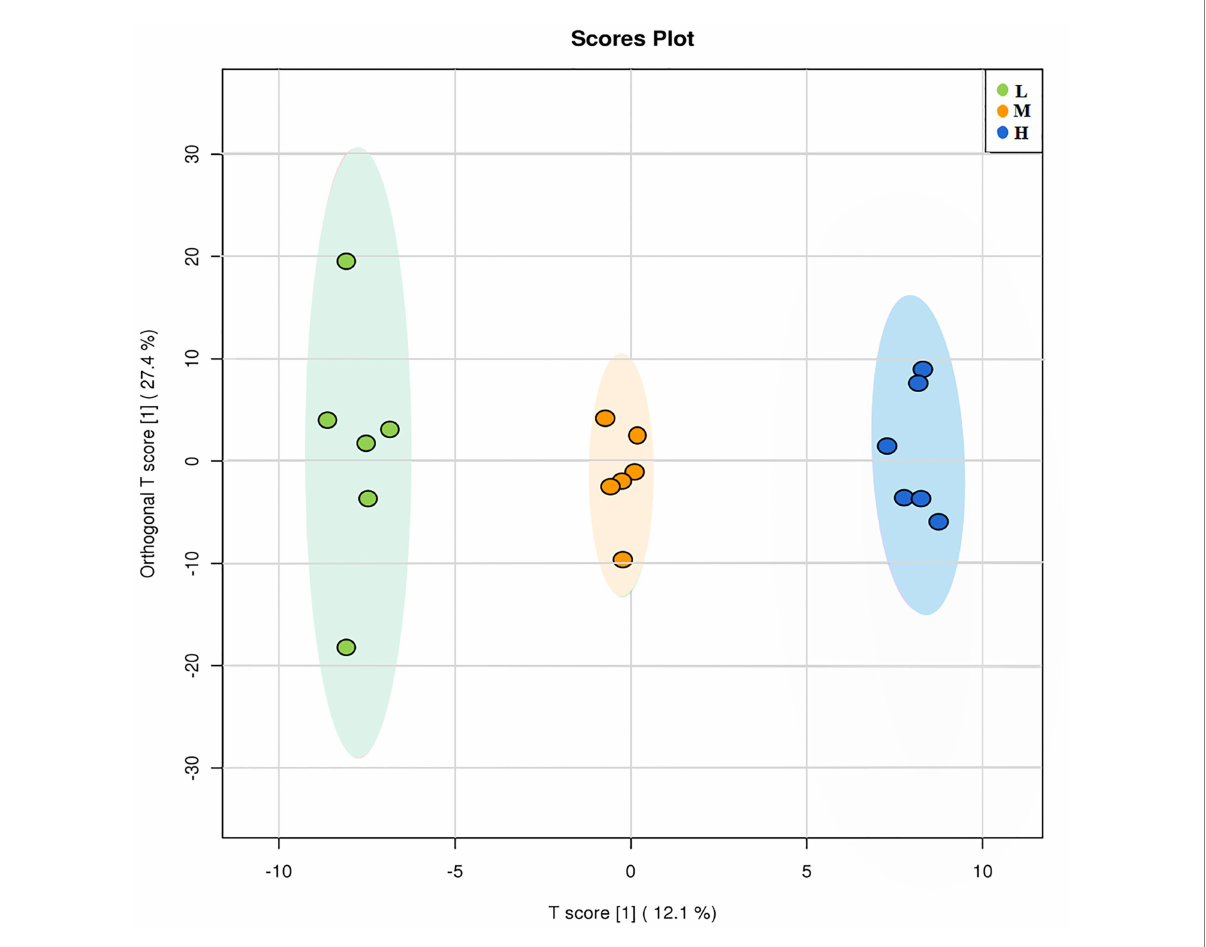
FIGURE 5 OPLS-DA of different degraded soil